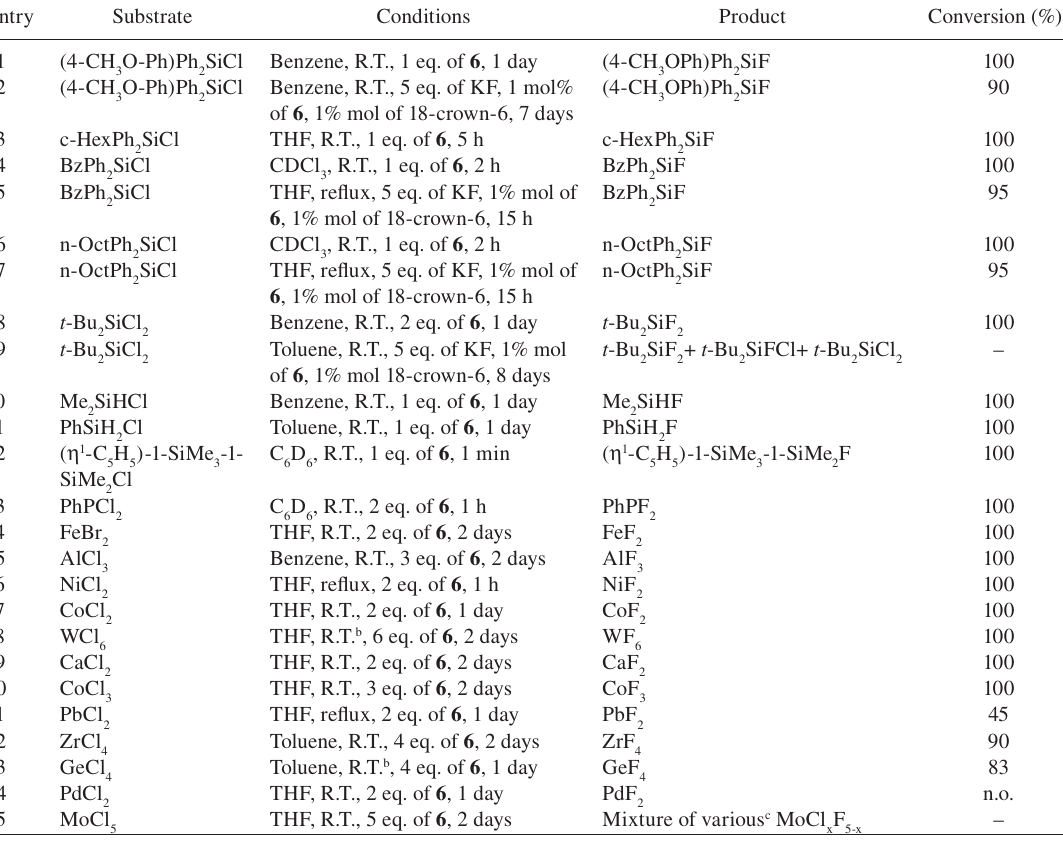
a Based on 1 H, 29 Si, 31 P and 119 Sn NMR spectra.